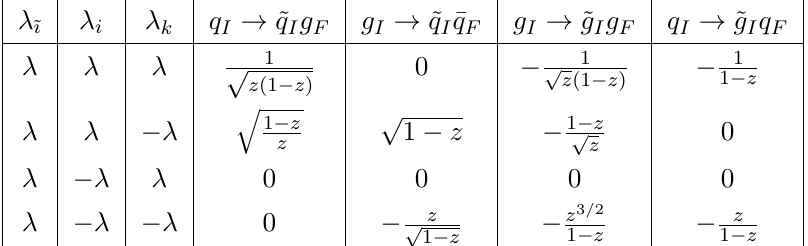
Table 1. The helicity-dependent Altarelli-Parisi splitting amplitudes F λ ˜ ı λ i λ k eq. (6.4), using the convention of eq. (2.2) where ˜ ı evolves backwards to i while emitting k such that p = z/ (1 − z )˜ p , p = 1 / (1 − z )˜ p . Aside from overall colour factors, the amplitudes k i i i